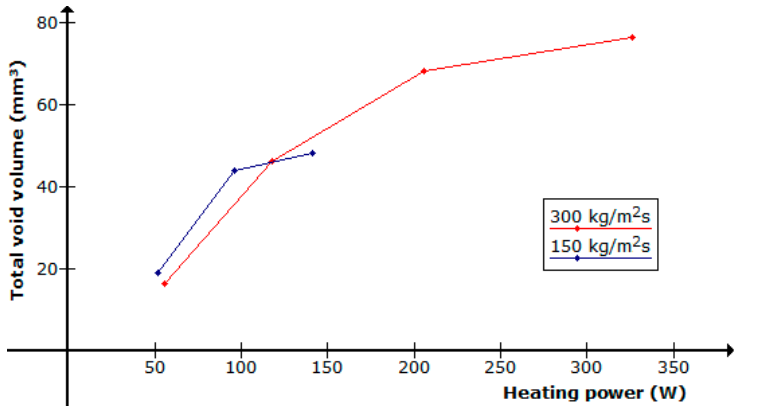
Figure 8. The total void volume present in the test section as a function of heating power and refrigerant mass flux. As image processing provides much more detailed information about the void distribution, the following figures show the void volume distributed over different bubble sizes. Bubble size distributions resulting from image analysis are shown as histograms of the total void volume as a function of equivalent bubble radius. In this way, the bubble sizes with a meaningful contribution to the total void in the test section can be determined. All distributions are normalized per image frame, indicating a time-averaged value of vapor in the test section at any given time. The distributions in Figure 9 show two different behaviors of the boiling flow. At 150 kg/m 2 s the distributions in higher heating power cases are quite scattered and without a pronounced peak. The distributions at 300 kg/m 2 s on the other hand, clearly show a single peak, regardless of the heating power at which they were measured. One notable difference is also the fact that at a lower refrigerant mass flux, somewhat larger bubbles are observed (1.4 mm vs 1.2 mm) and they represent a larger part of the total volume.